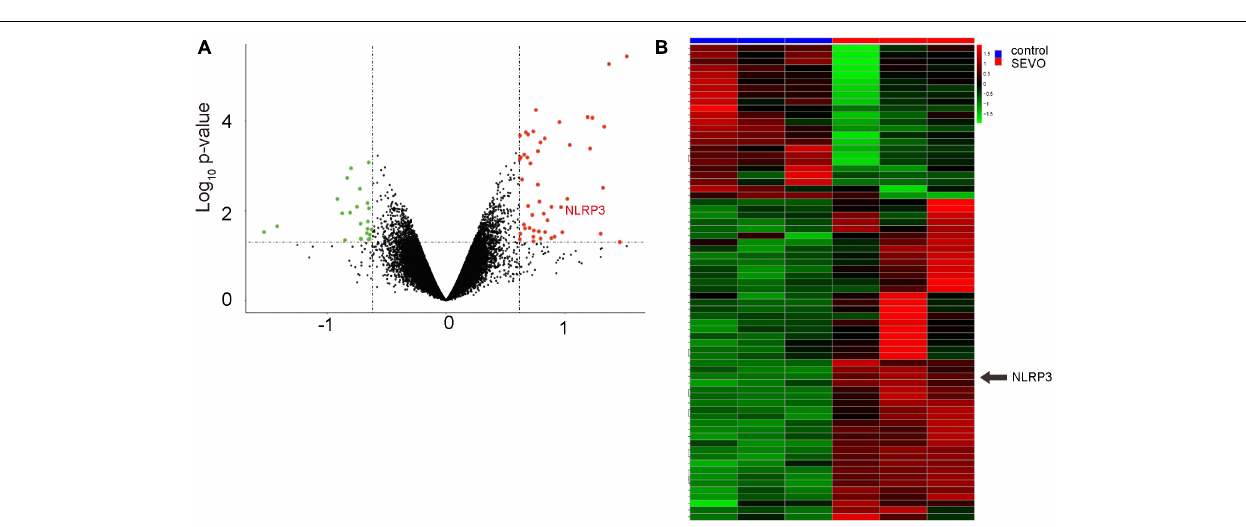
FIGURE 7 | Bioinformatic analysis shows that SEVO upregulates NLRP3 in brain. (A,B) Data from GSE141242 showed that SEVO indeed increased NLRP3 levels in brain, by a volcano map (A) and by a heat map (B)